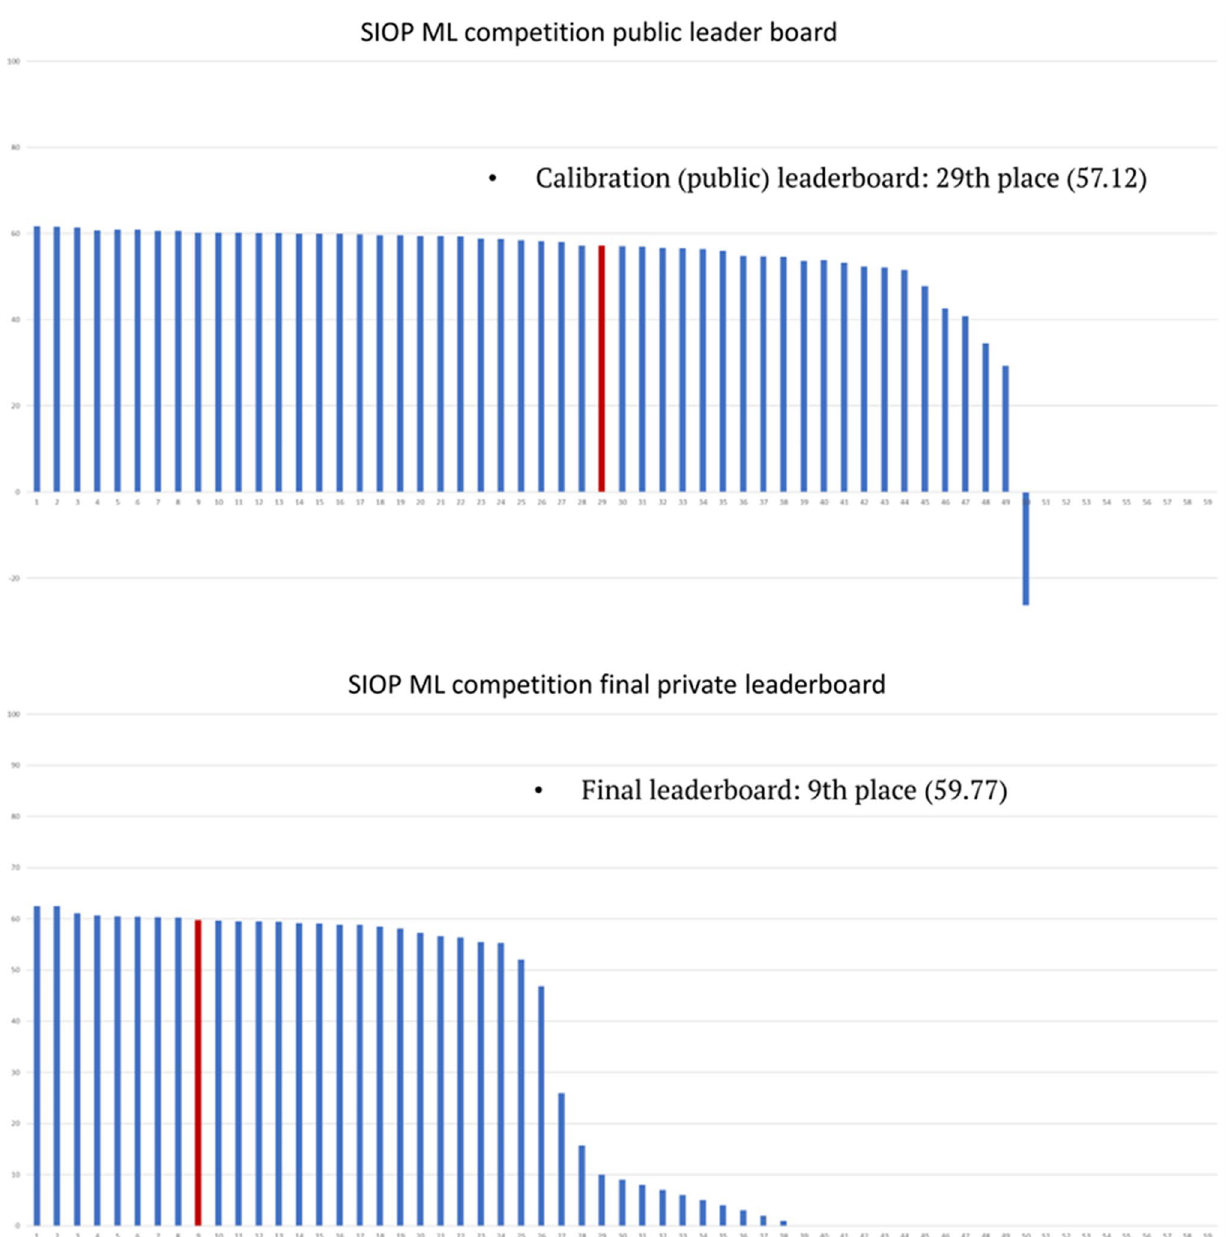
Fig. 2 Results from the 2020/21 SIOP Machine Learning competition. The final ranking of “Models for All” is shown in the public leaderboard (above) and the final private leaderboard